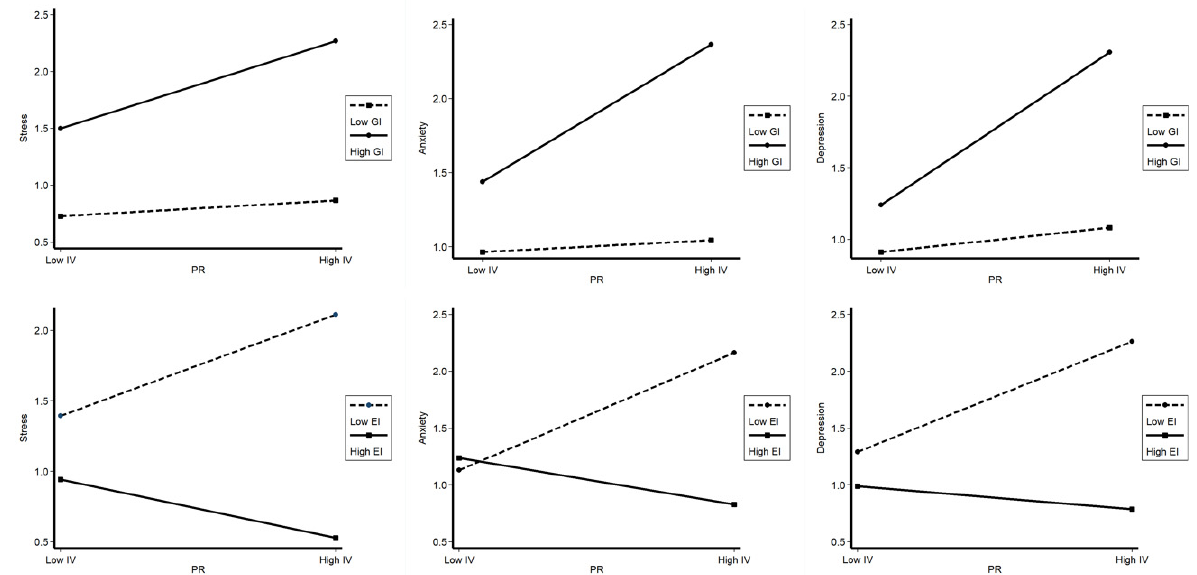
Figure 3. Visualizing the moderating effect of gender identity (GI) and engineering identity (EI).